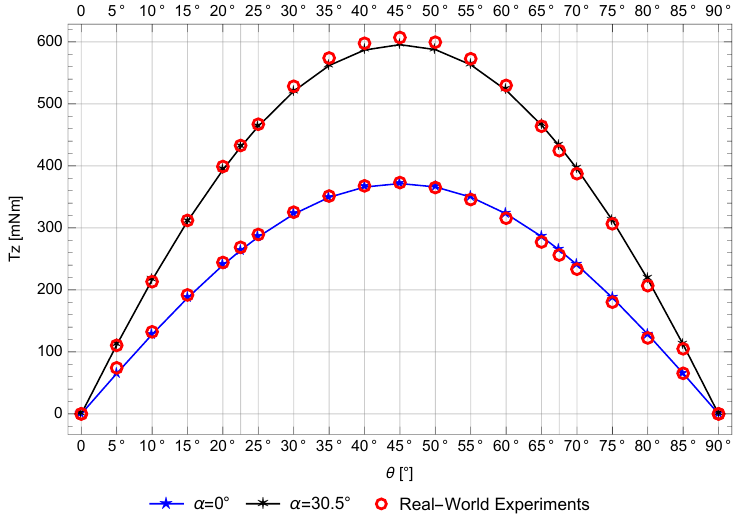
Figure 9. θ axis view of simulation and experimental results for the magnetic spring effect T z ( α = { 0 ◦ ,30.5 ◦ } , θ ) , validating the numerical model. It is possible to see that the maximum torques occur when θ = 45 ◦ whatever the α angle. For θ = 0 ◦ or 90 ◦ , T z is always